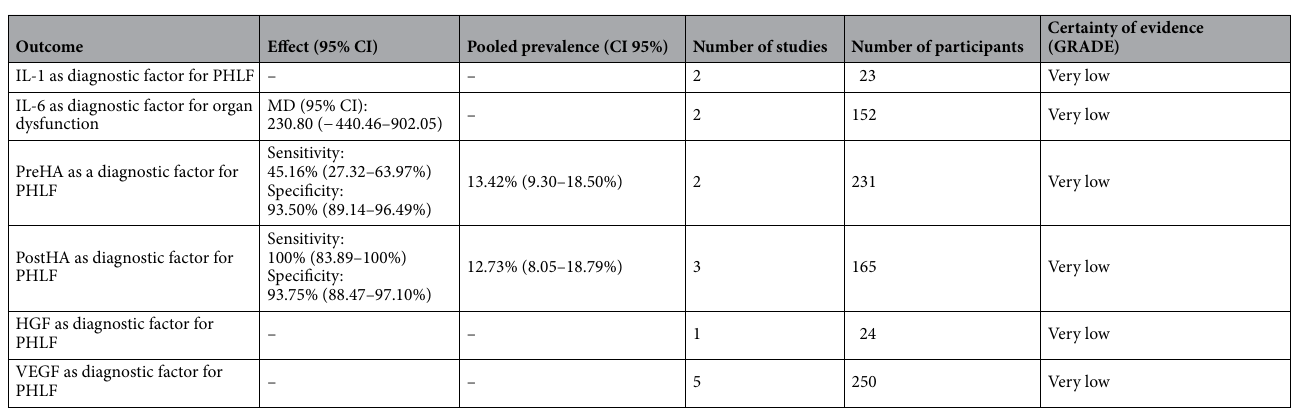
Table 2. GRADE summary of